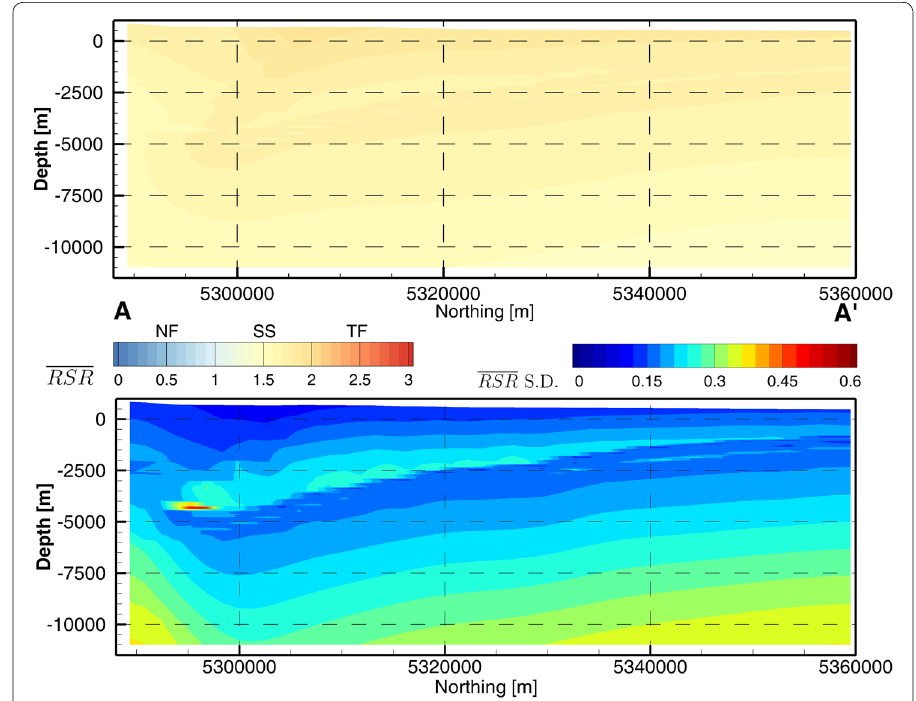
Fig. 8 The average regime stress ratio (RSR) (top) and its standard deviation (bottom) on the profile A – A ′ with a vertical exaggeration of 1:2. The southward dipping Malm units are clearly delineated by an increase in standard deviation. The RSR is a continuous scale from 0 to 3 to discuss the stress regime (Simpson 1997). A value of 0.5 is pure normal faulting (NF), 1.5 is pure strike‑slip faulting (SS), and 2.5 is pure thrust faulting